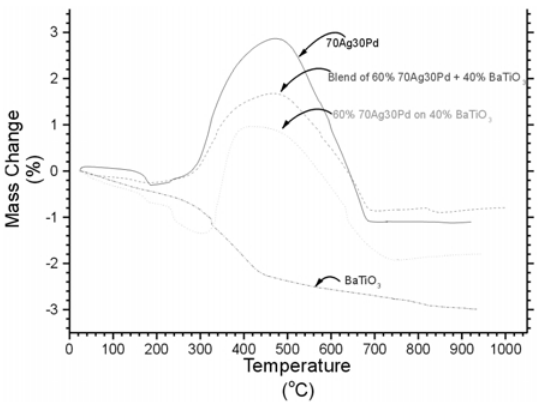
FIGURE 3 Thermal-gravimetric curves of 70%Ag30%Pd, 70%Ag30%Pd þ BaTiO 3 , 70%Ag30%Pd coated onto BaTiO